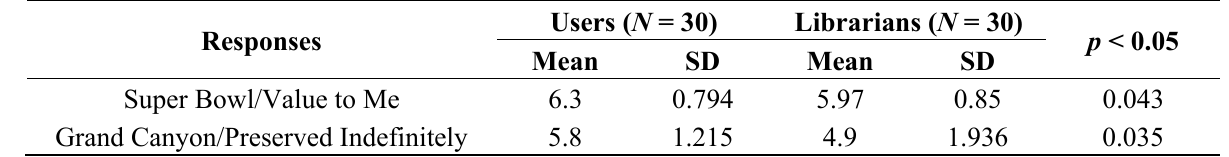
Table 3. Significantly different responses between users and